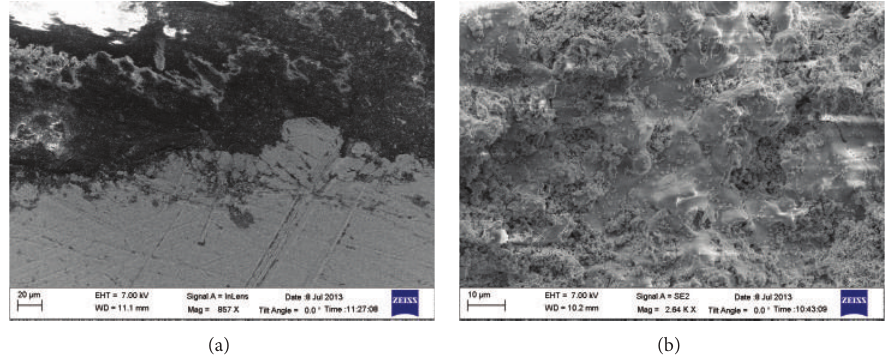
Figure 6: FESEM micrograph of as-sprayed nanostructured coating: (a) cross section, (b) surface.